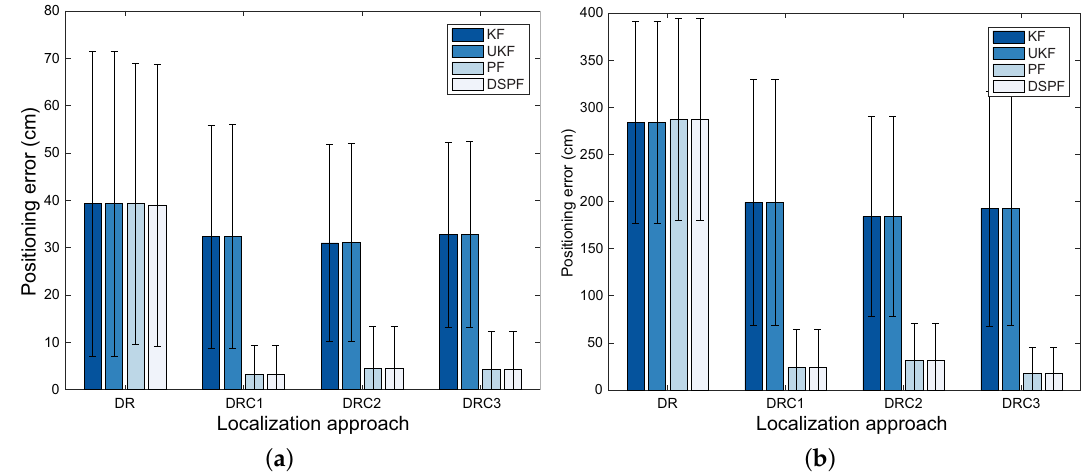
Figure 6. Positioning error of the localization schemes for test cases ( a ) TC1 and ( b )